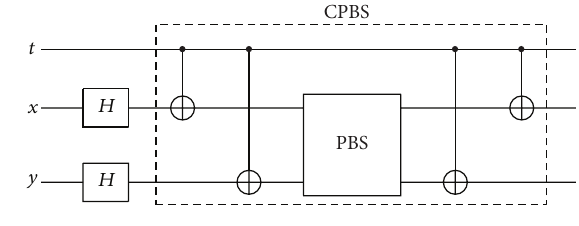
Figure 4: P-circuit Q 𝑡𝑥𝑦 [24, eq.